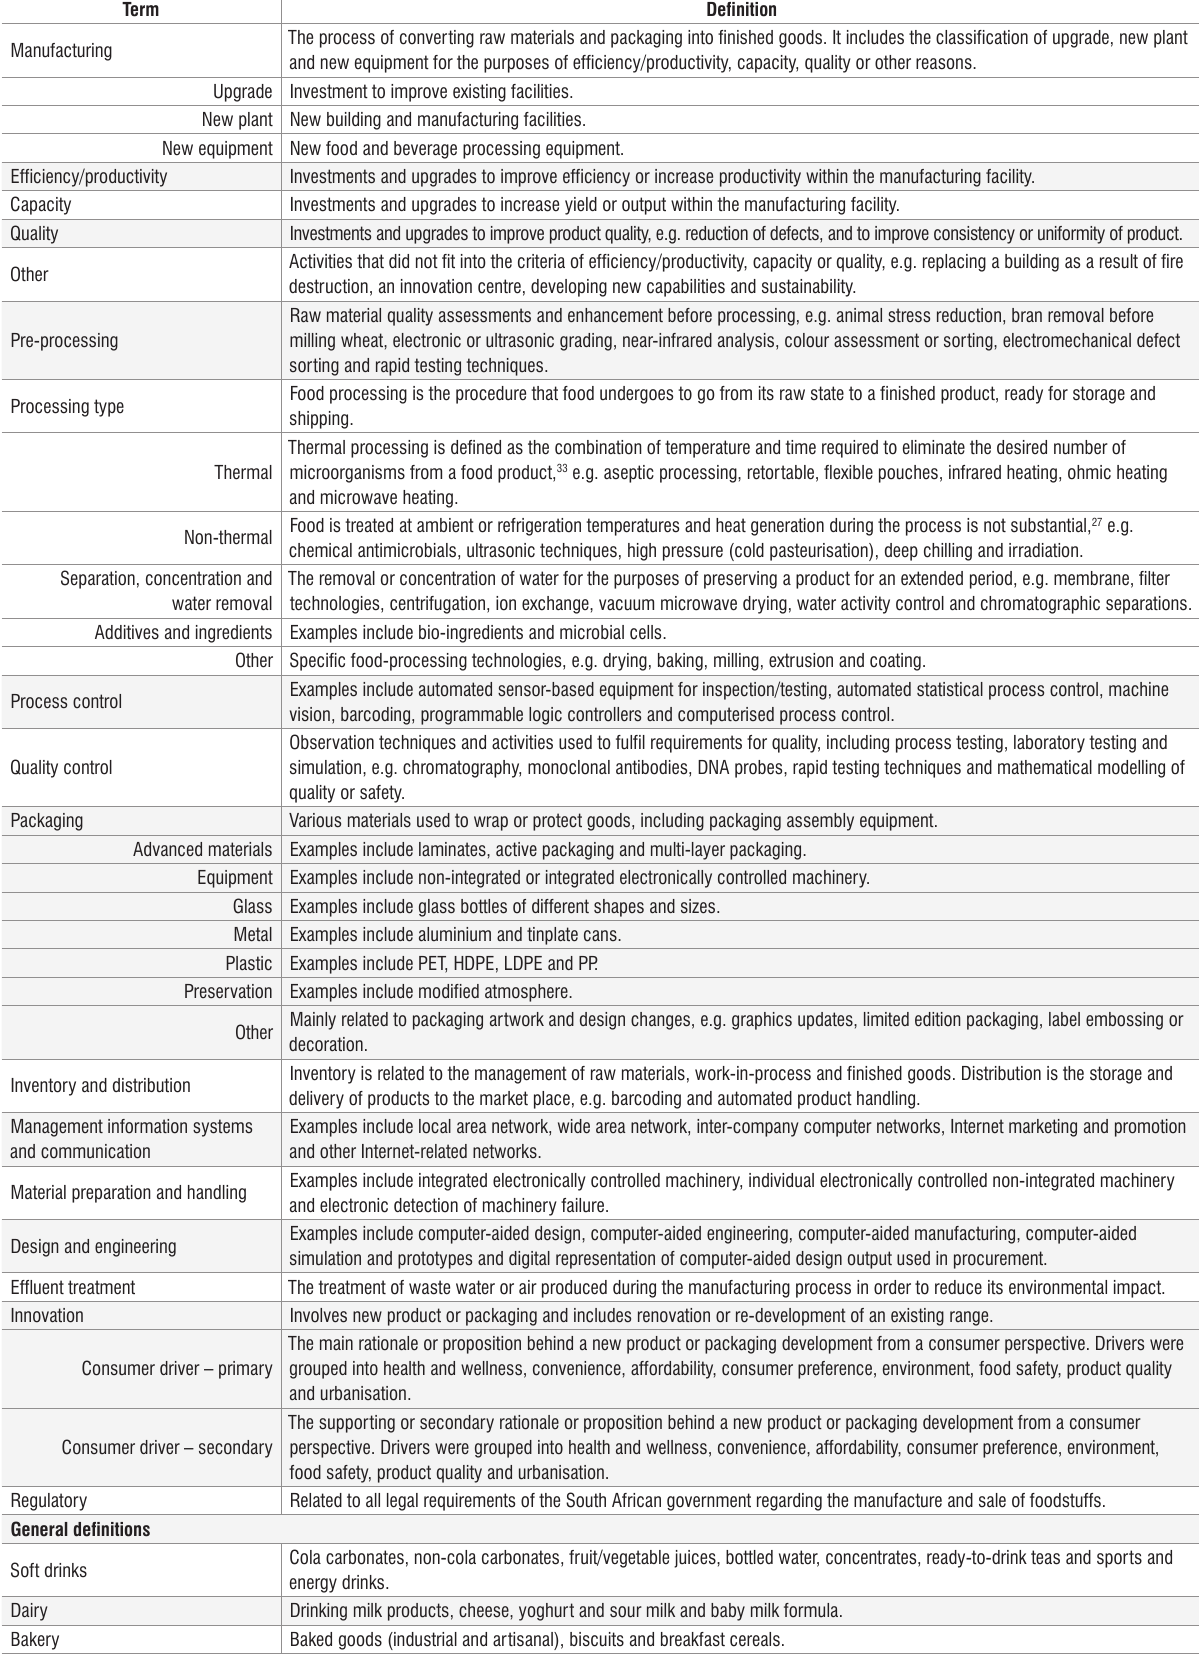
Table 1: Definitions and examples of the classification of activities in the South African food and beverage manufacturing industry (adapted and extended from Fryer & Versteeg 30 and Baldwin et al. 48 ) and general